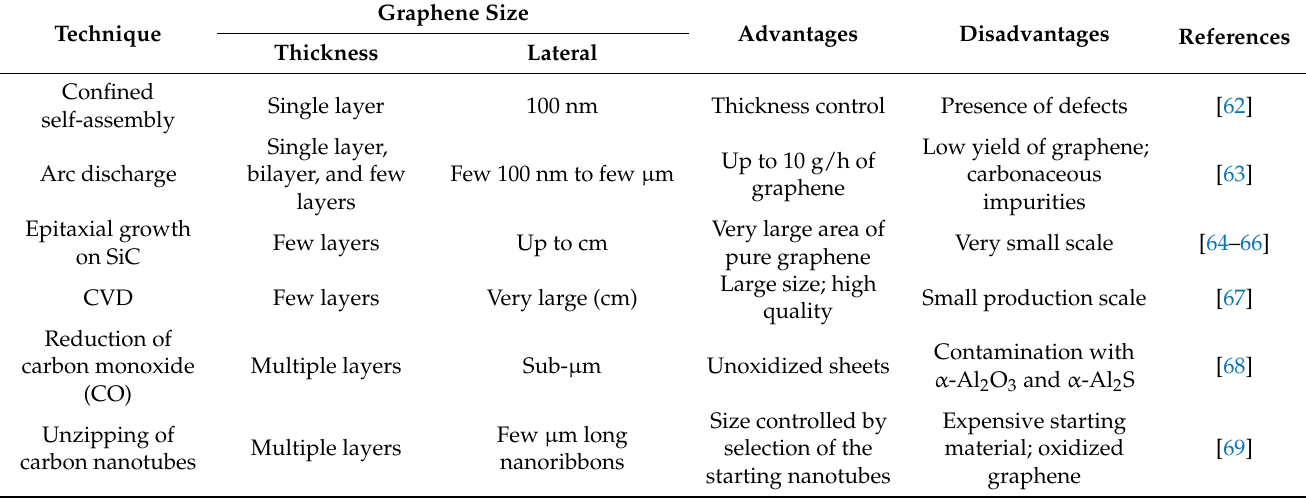
Table 1. Bottom-up techniques for producing graphene sheets. For each technique, the size of gra- phene sheets that can be obtained and the related advantages/disadvantages are reported.